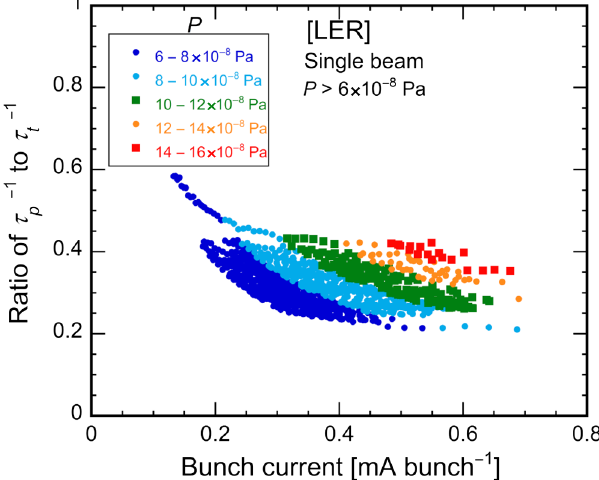
FIG. 16. Ratio of the first term ( 1 = τ p ) to the second term ( 1 = τ t ) of the right-hand side of Eq. (14) for the several pressure ranges of 6 × 10 − 8 – 1 . 6 × 10 − 7 Pa for the